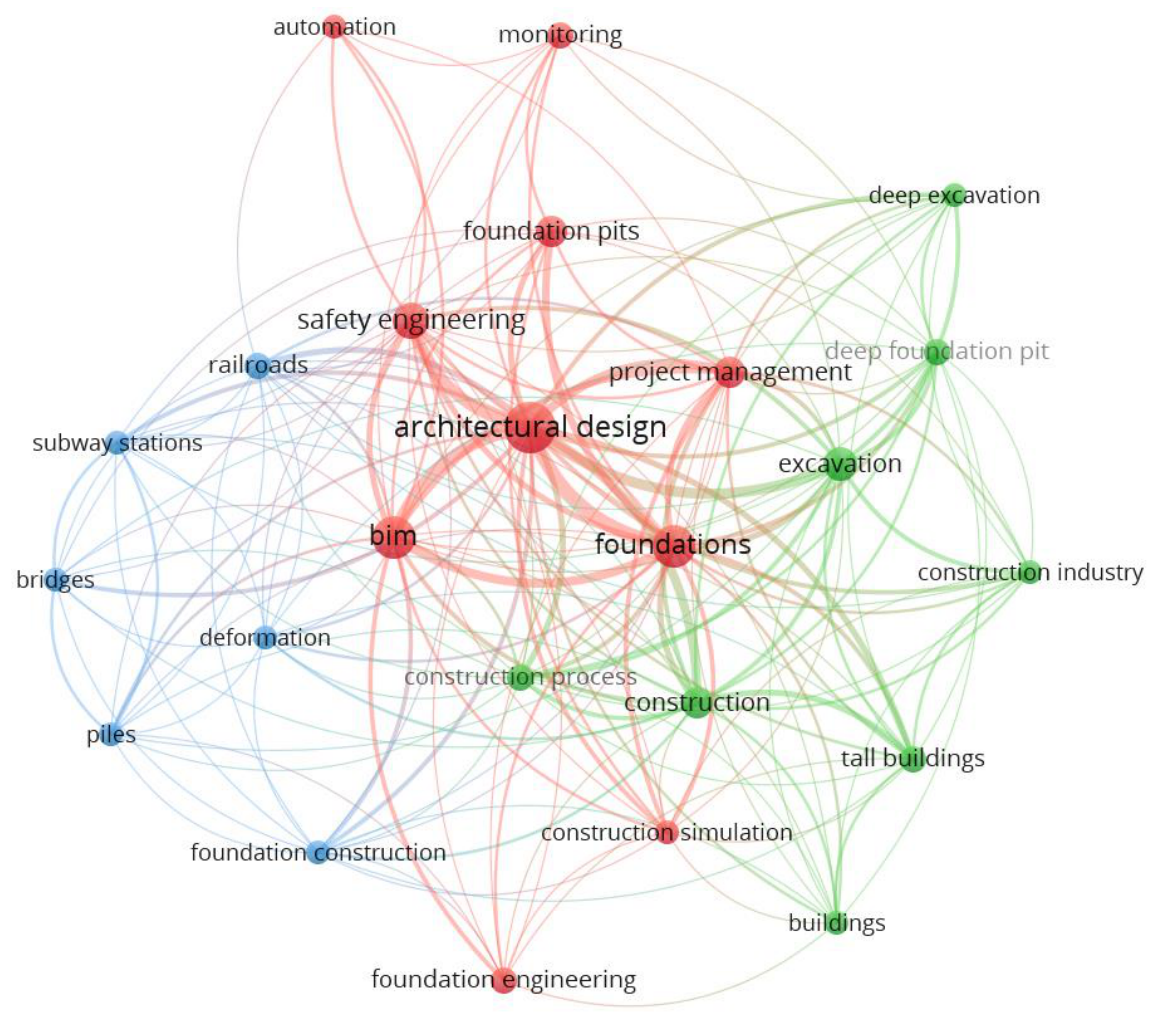
Figure 1. Mapping analysis of co-occurrence of keywords related to intelligent foundation pit engi- neering.